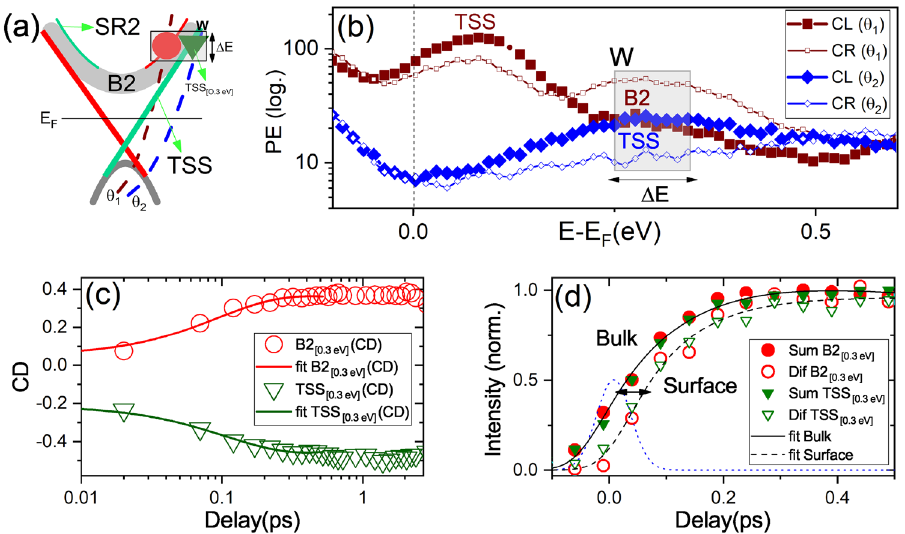
Figure 3. Panel ( a ) schematically represents the two angles θ 1 (brown) and θ 2 (blue) at which the data of panels ( b )–( d ) were acquired. The black dashed window (W) shows the energy-momentum region where B2 [ 0.3 eV ] (red circle) and TSS [ 0.3 eV ] (green triangle) are at the same energy level (see (cid:31) E in Fig. 2a ). Panel ( b ) shows the logarithmic EDCs at θ 1 (brown) and θ 2 (blue) taken with circular right (thin) and circular left (thick) probe polarization. ( c ) The time dependent CD of B2 [ 0.3 eV ] and TSS [ 0.3 eV ] . Solid lines are the corresponding exponential fits. ( d ) The dynamics of sum (S) and (D) difference circular light. Solid line is corresponding fit of S and dashed line of D. The dotted Gaussian profile represents the instrumental response